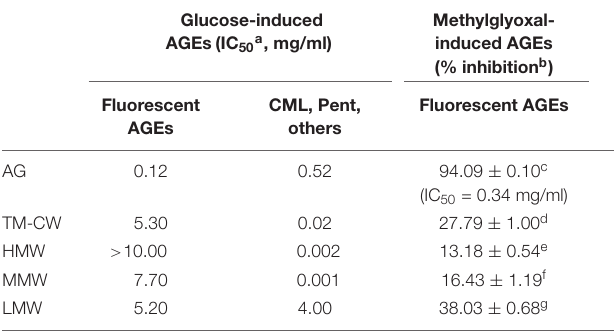
TABLE 4 | Inhibitory effects of the Sephadex R (cid:13) fractions on AGEs formation in vitro , induced by glucose and methylglyoxal. Glucose-induced AGEs(IC 50a , mg/ml)